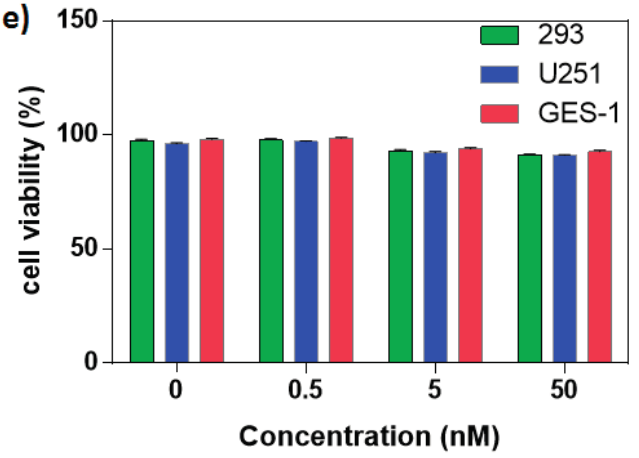
Figure 3. ( a ) Photoluminescence (PL) decay profiles of CdTe QDs and dendrimer modified CdTe/CdS QDs; ( b ) Effect of different buffer on the fluorescence intensity of dendrimer modified CdTe/CdS QDs at different time intervals; ( c ) Effect of different buffers on the fluorescence intensity of dendrimer modified CdTe/CdS QDs at different time intervals; ( d ) Cell viability of 293T cells after incubation with PBS buffer, bulk CdTe QDs and dendrimer modified CdTe/CdS QDs at 24 h and 48 h, respectively; ( e ) Cell viabilities of 293T cells, U251 cells and gastric epithelial cell line (GES-1) cells after incubating with various concentrations (0.5, 5, and 50 nM) of freshly prepared QDs for 24 h. The 0 nM concentration of QDs is taken as a